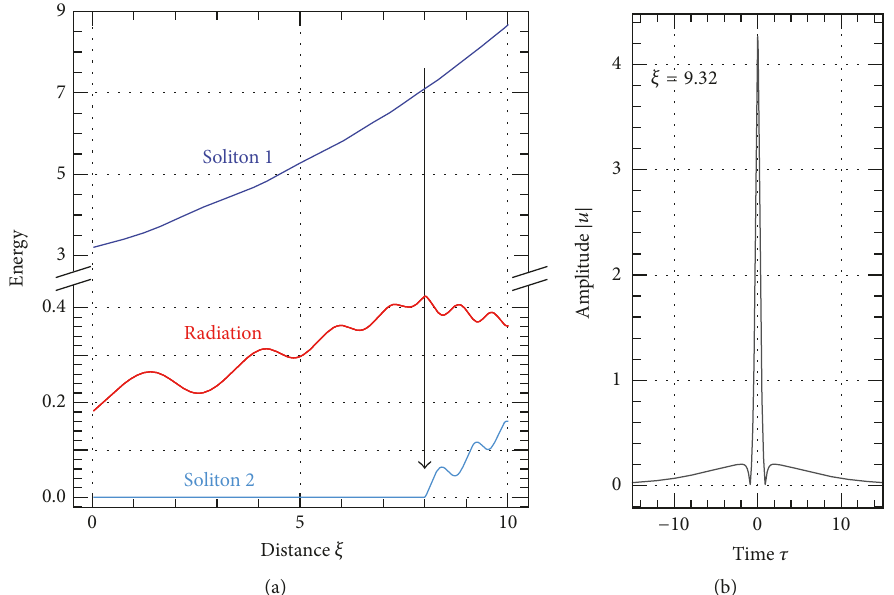
Figure9:(a)Evolutionoftheenergiesofbothsolitonsandradiationat 𝛾 = 0.1 ,calculatedfromDirectScatteringTransform.Initialconditions were 𝑁 = 1.3 and 𝜂 = 1.0 . Note the break in the scale. The point of creation of the second soliton is highlighted by an arrow. (b) Example of a pulse envelope taken at 𝜉 = 9.32 where the pulse consists of two solitons and